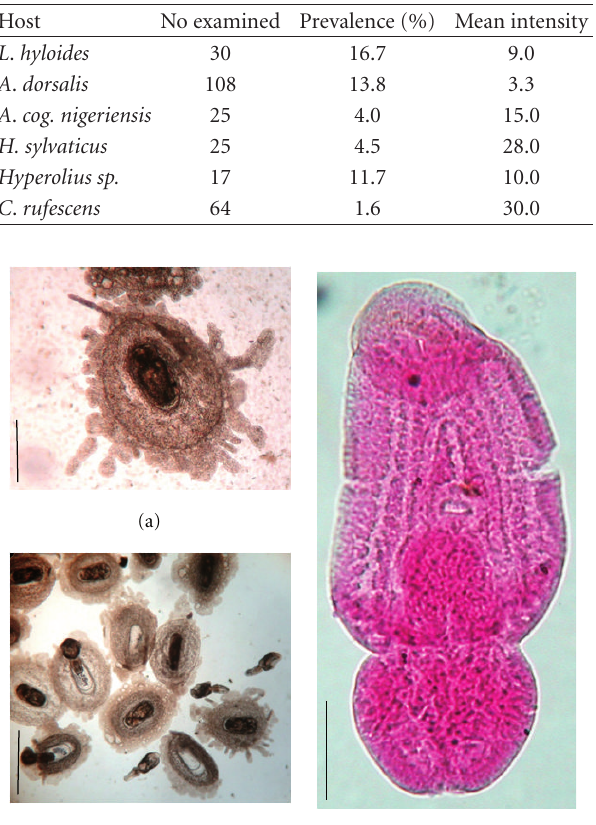
Table 1: Prevalence of strigeoid trematode metacercariae in tree frogs at the Okomu National Park.